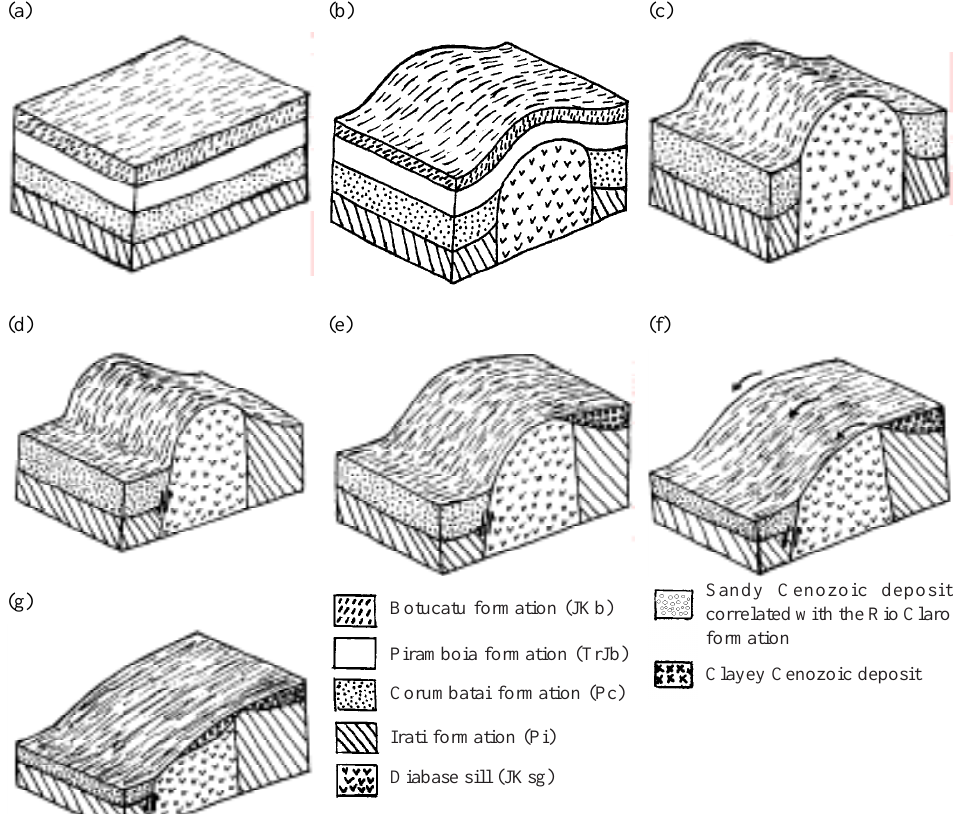
Figure 2. Stratigraphic and landscape evolution of the region in which the study area is situated. (a) Hypothetical stratigraphy and landscape before the intrusion of the sill (Jurassic-Triassic); (b) Intrusion of the sill in faults and fractures formed during the higher Permian deforming the sedimentary strata; (c) Excavation of the Peripheric Depression exposing the diabase sill forming the tectonic barriers (between the Oligocene and Pliocene), (d) Reactivation of old faults during the Peripheric Depression formation lifting the diabase sill and the Irati formation and lowering the Corumbataí formation; (e) Deposition of fine sandy sediments that correlate with the Rio Claro formation on the lithological barriers during a probably drier climate, (f) Pedimentation phase depositing, at a lower position, reworked material from the diabase and Rio Claro formation; (g) Actual aspect of the stratigraphy and